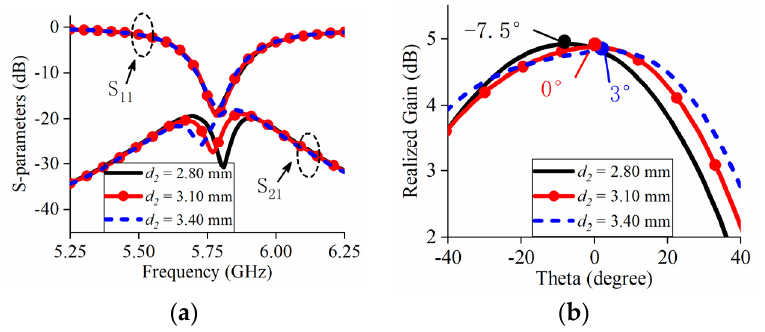
Figure 2. The effect of 𝑑 (cid:2870) on antenna performance: ( a ) S-parameters and ( b ) radiation patterns.